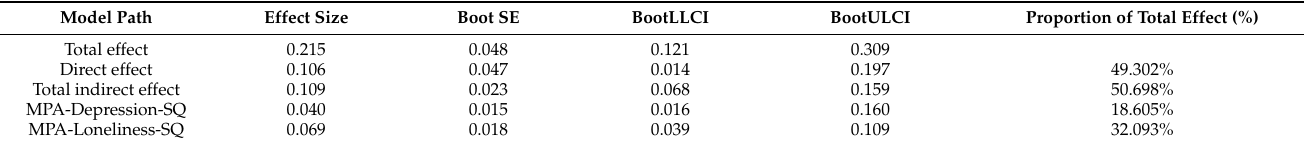
Table 3. Effects of mobile phone addiction on sleep